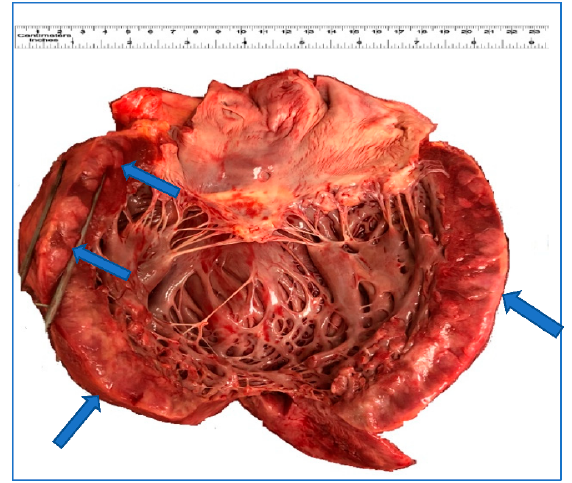
Figure 1. Gross appearance of the heart. The left myocardium shows and focal thickening and white-brown discoloration (arrow) that corresponds to leukemic infiltration.